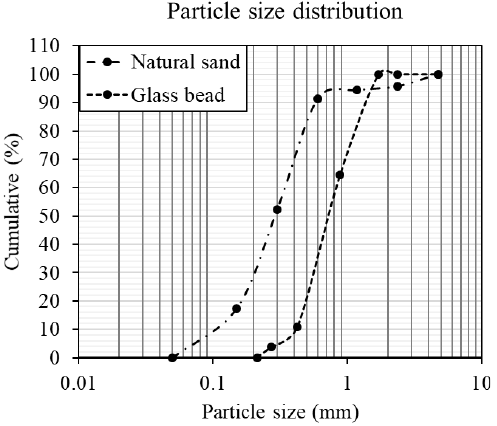
Figure 2. Particle size distribution of natural sand and glass beads. Table 1. Mix proportions of OC and GC (kg/m 3 ).